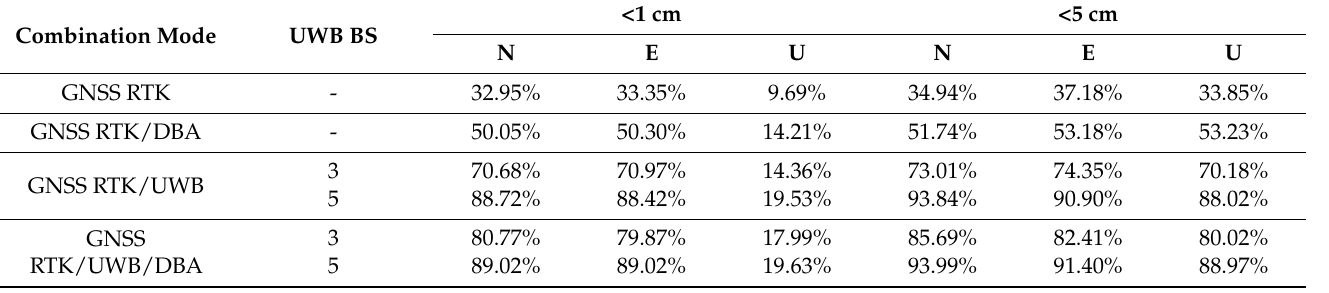
Table 9. Statistics of the GNSS RTK/UWB/DBA fusion positioning model error distribution intervals at a 50 degrees elevation mask angle in the dynamic cart scenario.